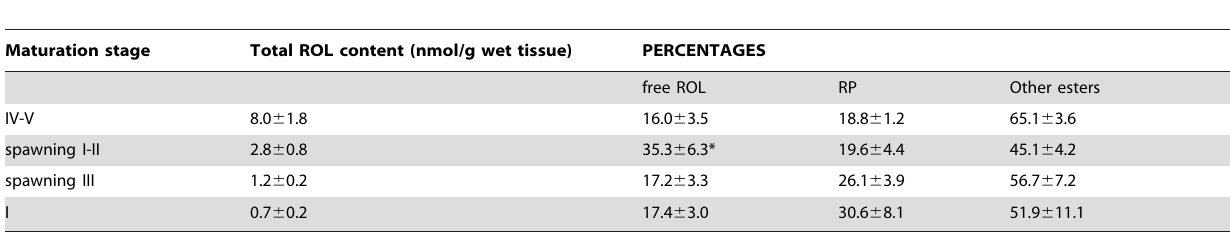
Table 1. Partition of retinol (ROL) among free ROL, retinyl palmitate (RP) or other esters in digestive gland-gonad complexes of male O. lineatus (n=4–8) in different sexual maturation stages.